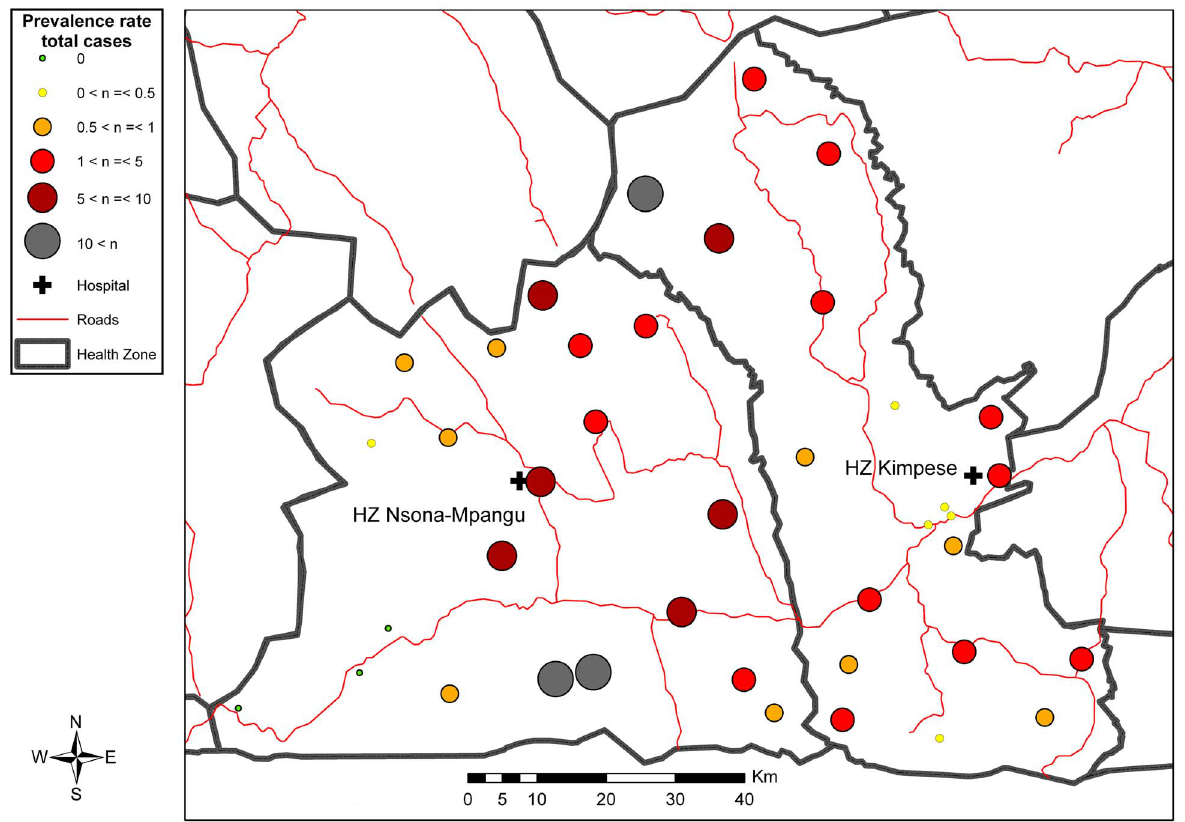
Figure 2. Distribution of total number of BU cases (active and inactive) in the Songololo Territory, July–August 2008.